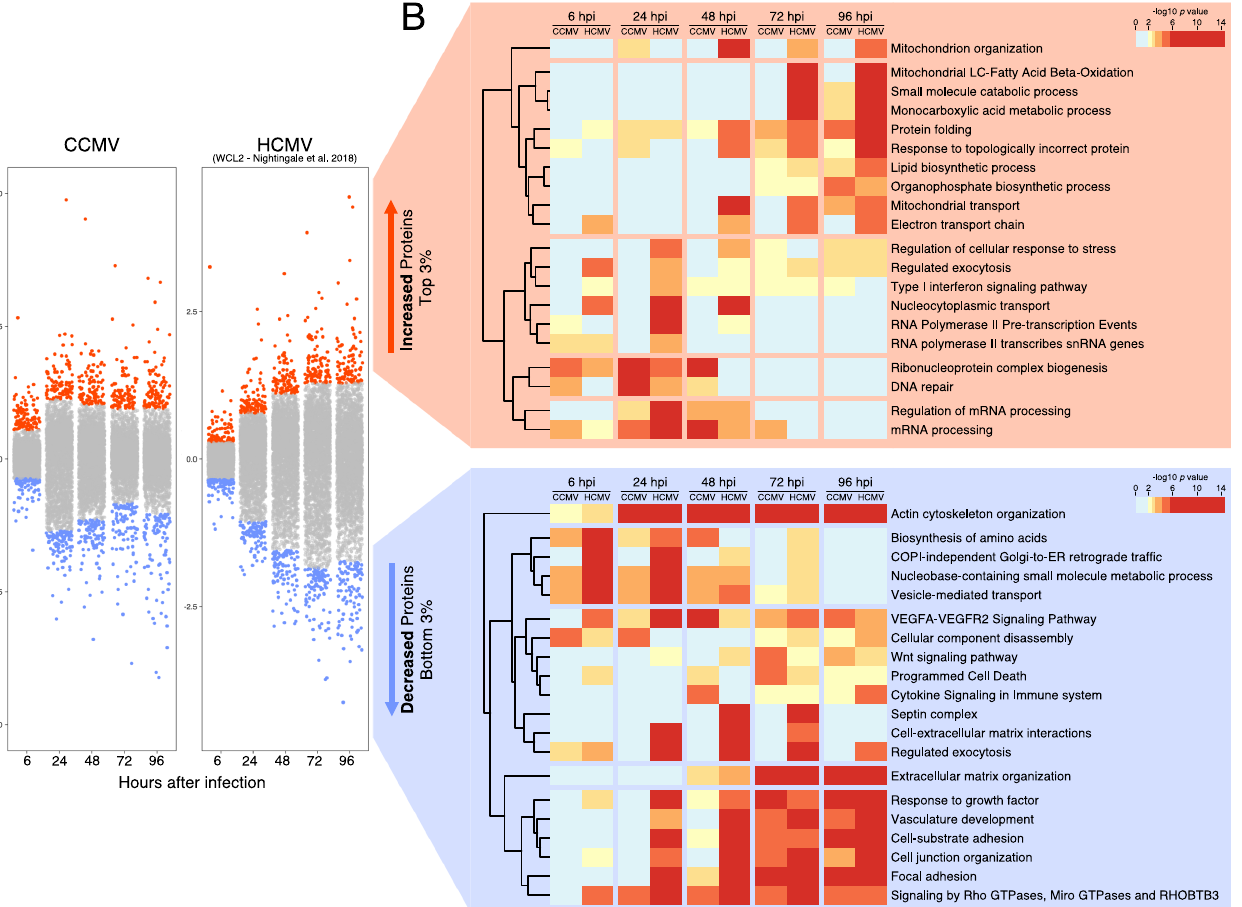
Fig 7. Gene ontology (GO) analysis of the most deregulated host proteins during CCMV and HCMV infection. (A) For each time point post infection, fold-changes in host protein expression were calculated relative to uninfected control cells (0 h). The top and bottom 3% of protein fold-changes were selected from each time point and used for multi-list GO enrichment analysis. (B) Heatmap showing the GO terms for strongly increased or depleted proteins during HCMV and CCMV infection (LC: long chain). The HCMV data set WCL2 was taken from [47].